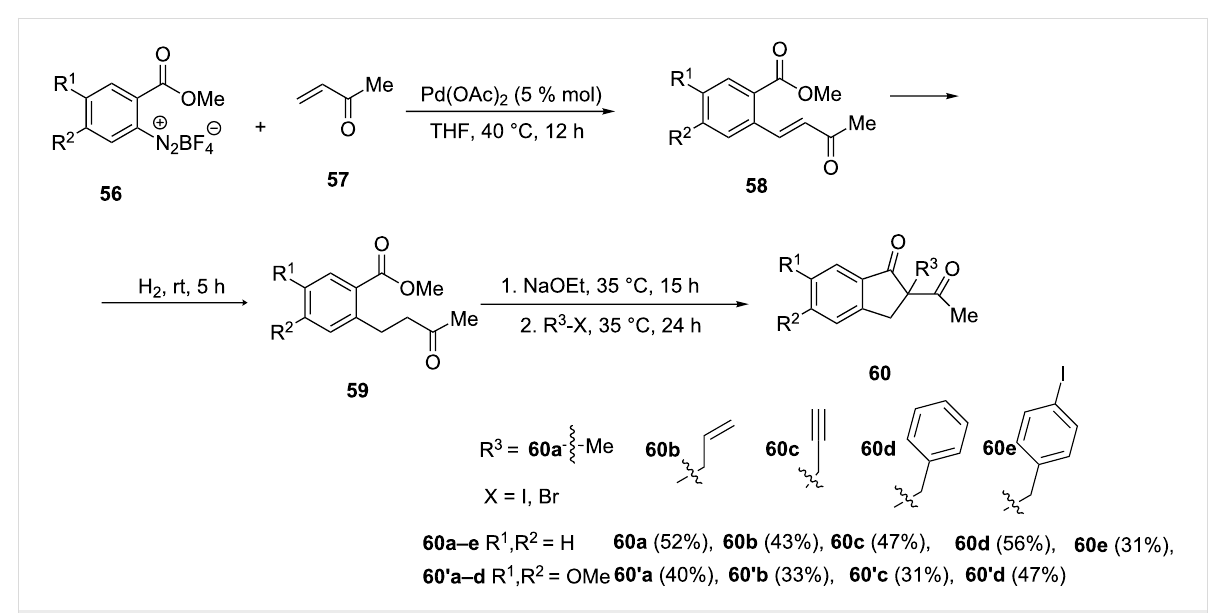
Scheme 20: Synthesis of 1-indanones 60 from methyl vinyl ketone ( 57